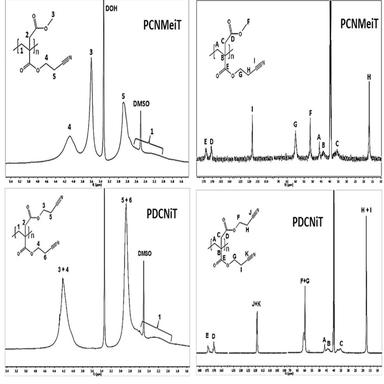
13C NMR spectra of PCNMeiT (up), PDCNiT (bottom). DMSO‑d6 was used as solvent.